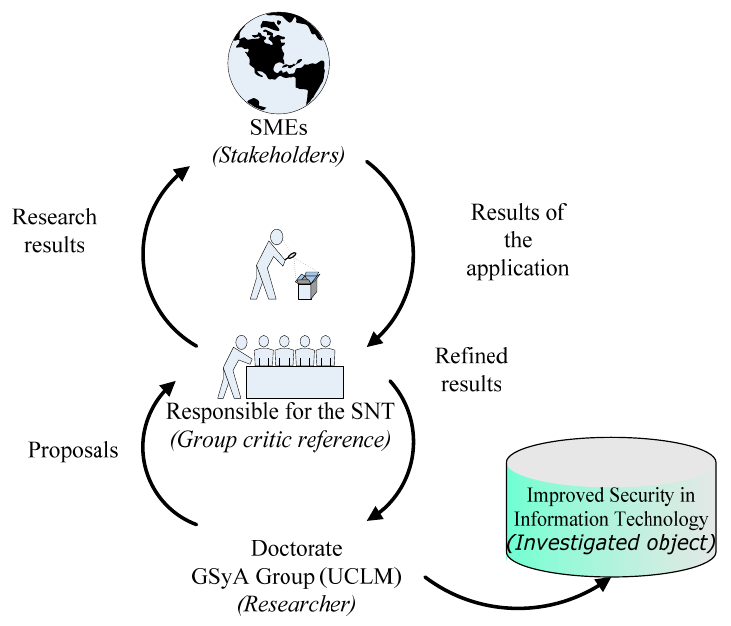
Figure 1. Application of Action Research during research.